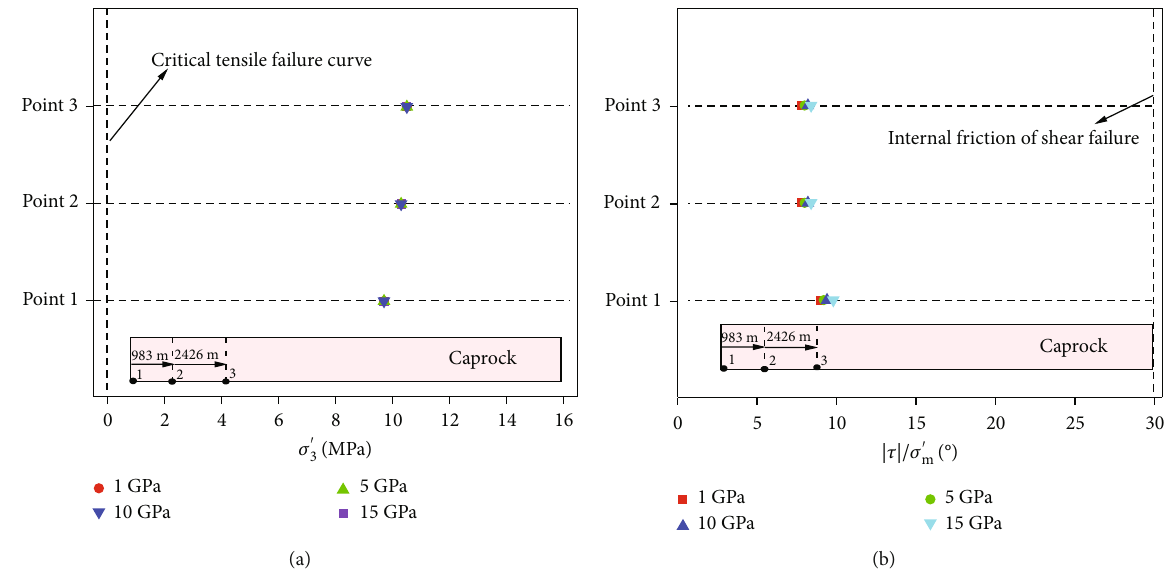
Figure 24: In fl uence of elastic modulus of caprock on mechanical integrity of caprock. (a) The minimum principal stress. (b) Critical internal friction angle.